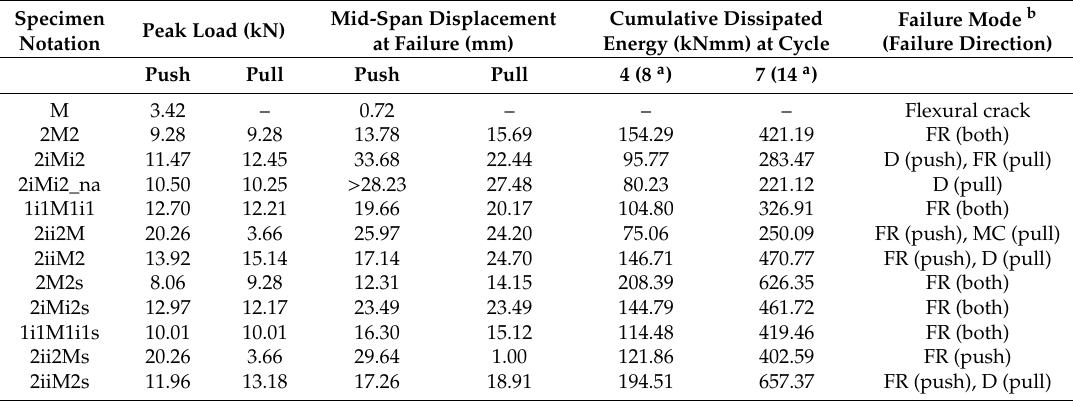
Table 1. Summary of three-point bending